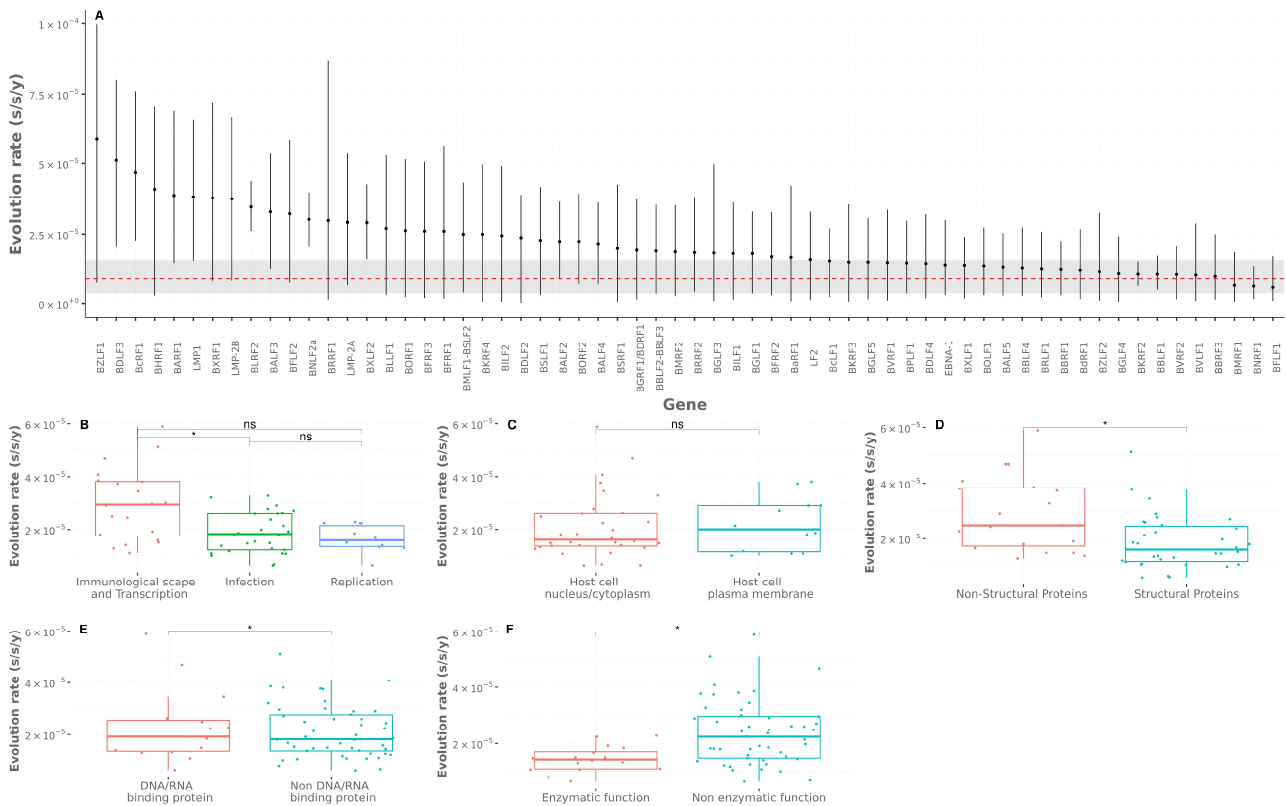
Figure 6. Analysis of evolutionary rates: ( A ) evolution rates for 60 analyzed genes, where dots depict mean evolution rates, error bars indicate 95% HPDI (highest posterior density interval), the red dotted line depicts the genome’s mean evolution rate, and the gray horizontal stripe denotes the 95% HPDI for the genome´s mean evolution rate; ( B – F ) comparison of the genes’ evolution rates among different groups contained in the biological categories (gene names listed in Table 1). Results are depicted in box plots. Asterisks denote statistical significance. Adjusted p -value < 0.05 (*); adjusted p -value > 0.05